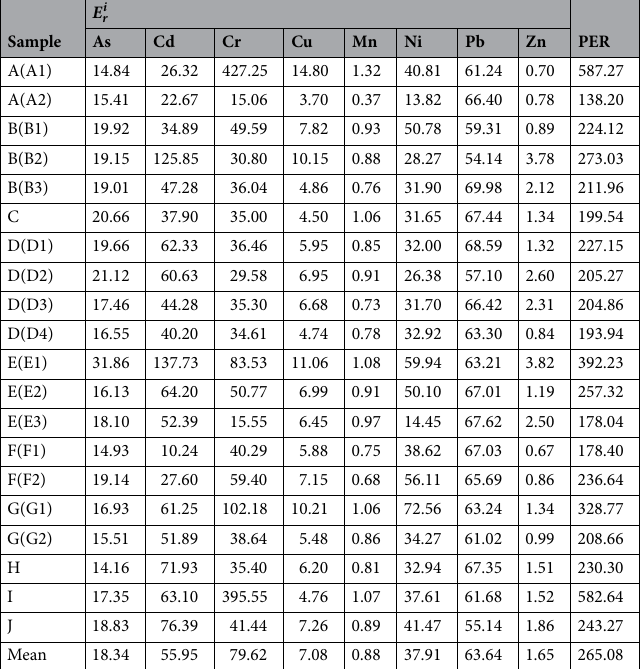
Table 2. Single ecological risk index and potential ecological risk of soil PTEs in study area.